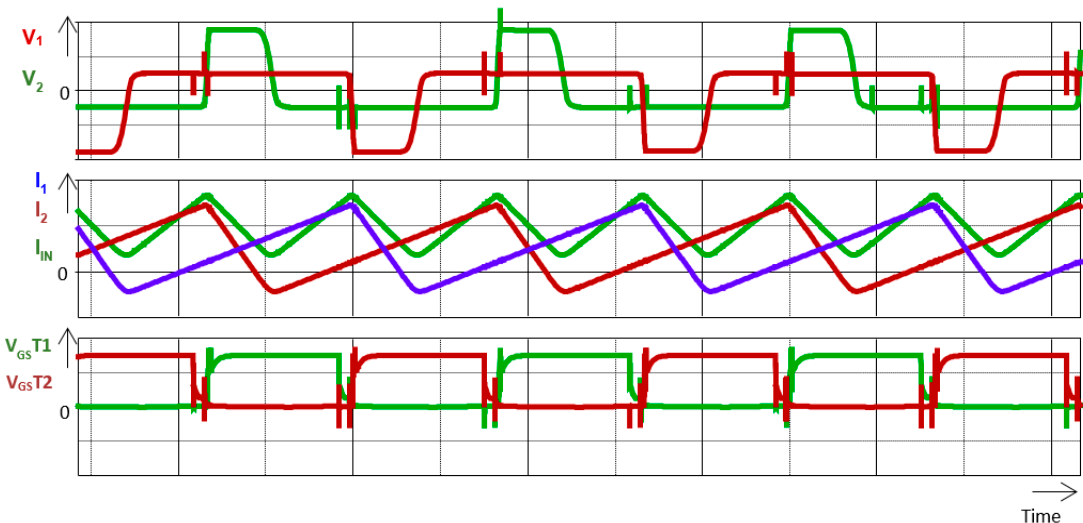
Figure 2. Operational waveforms of a dual interleaved boost converter with coupled inductors during CCM operation.